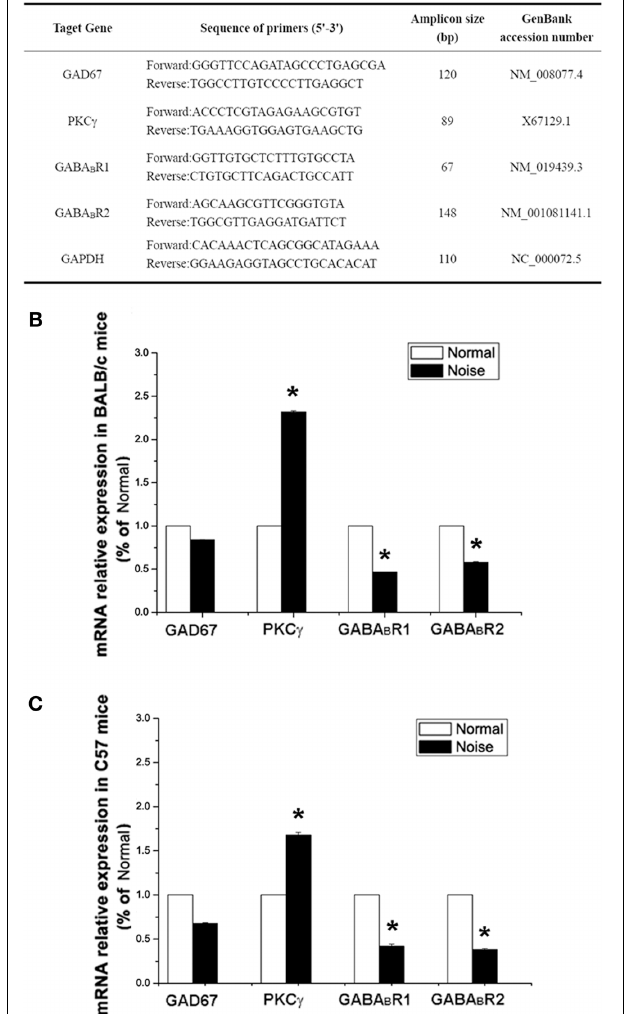
FIGURE 5 | The alterations of GAD67, GABA B R1, GABA B R2 and PKC γ at mRNA levels after noise exposure in BALB/c mice and C57 mice. (A) Sequences of specific primers and associated amplicon lengths for Real-Time PCR. (B) The noise-induced changes of GAD67, GABA B R1, GABA B R2, and PKC γ mRNA levels in BALB/c mice of each group. The sample of control group was set as 100%. (C) The noise-induced changes of GAD67, GABA B R1, GABA B R2, and PKC γ mRNA levels in C57 mice. The sample of control group was set as 100%. ∗ P < 0 . 05.